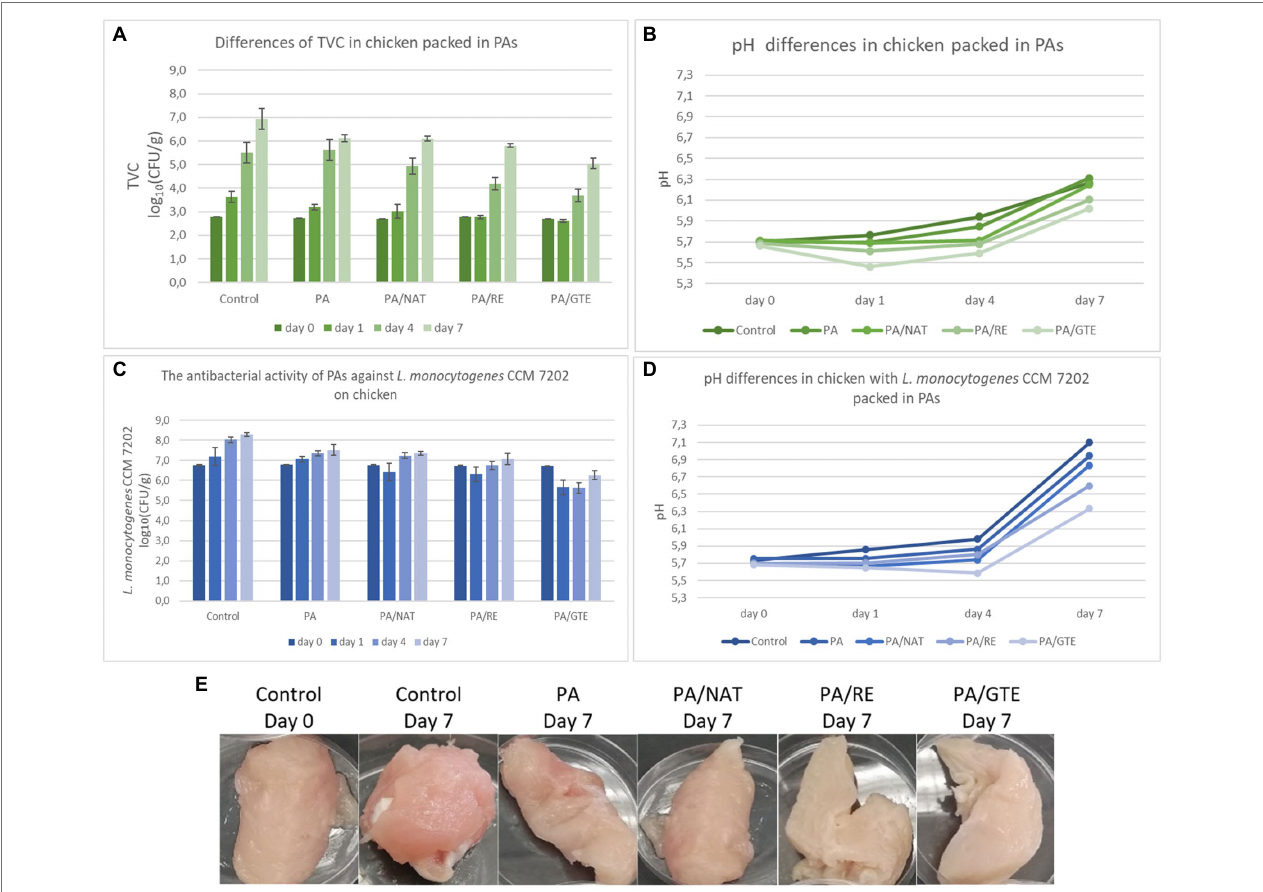
FIGURE 4 | The antimicrobial activity of PAs against L. monocytogenes CCM 7202 on chicken samples (A) and differences in pH (B) after 7 days storage at 7 ° C; the influence of PAs on total viable count (TVC) of microorganisms in non-inoculated chicken samples (C) , differences in pH (D) , and appearance change (E) after 7 days storage at 7 °